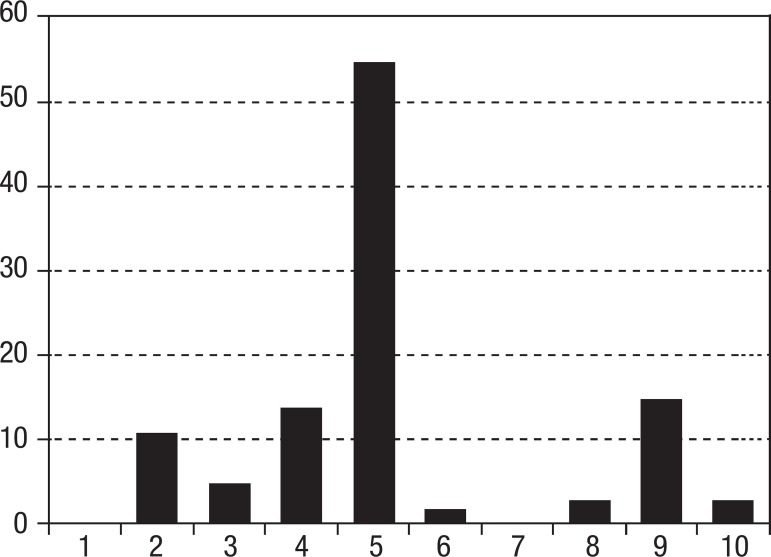
Histogram showing the frequency of CDT scores according to the scoring
system developed by Sunderland et al.10.